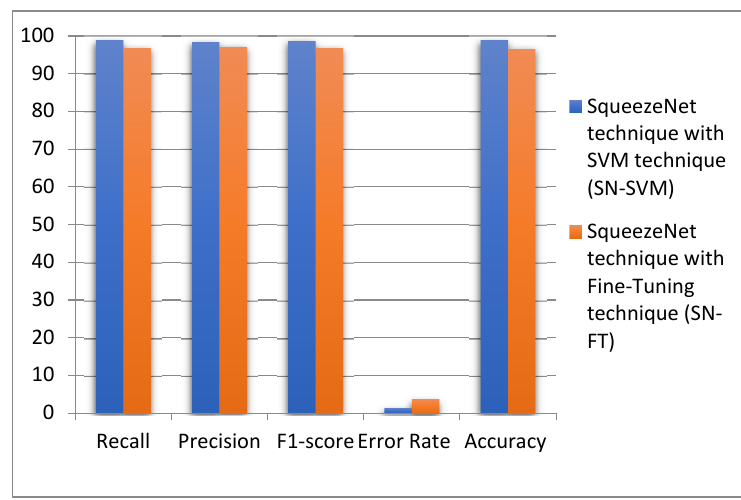
Table 4. Results of the performance of the SN-SVM and SN-FT methods.